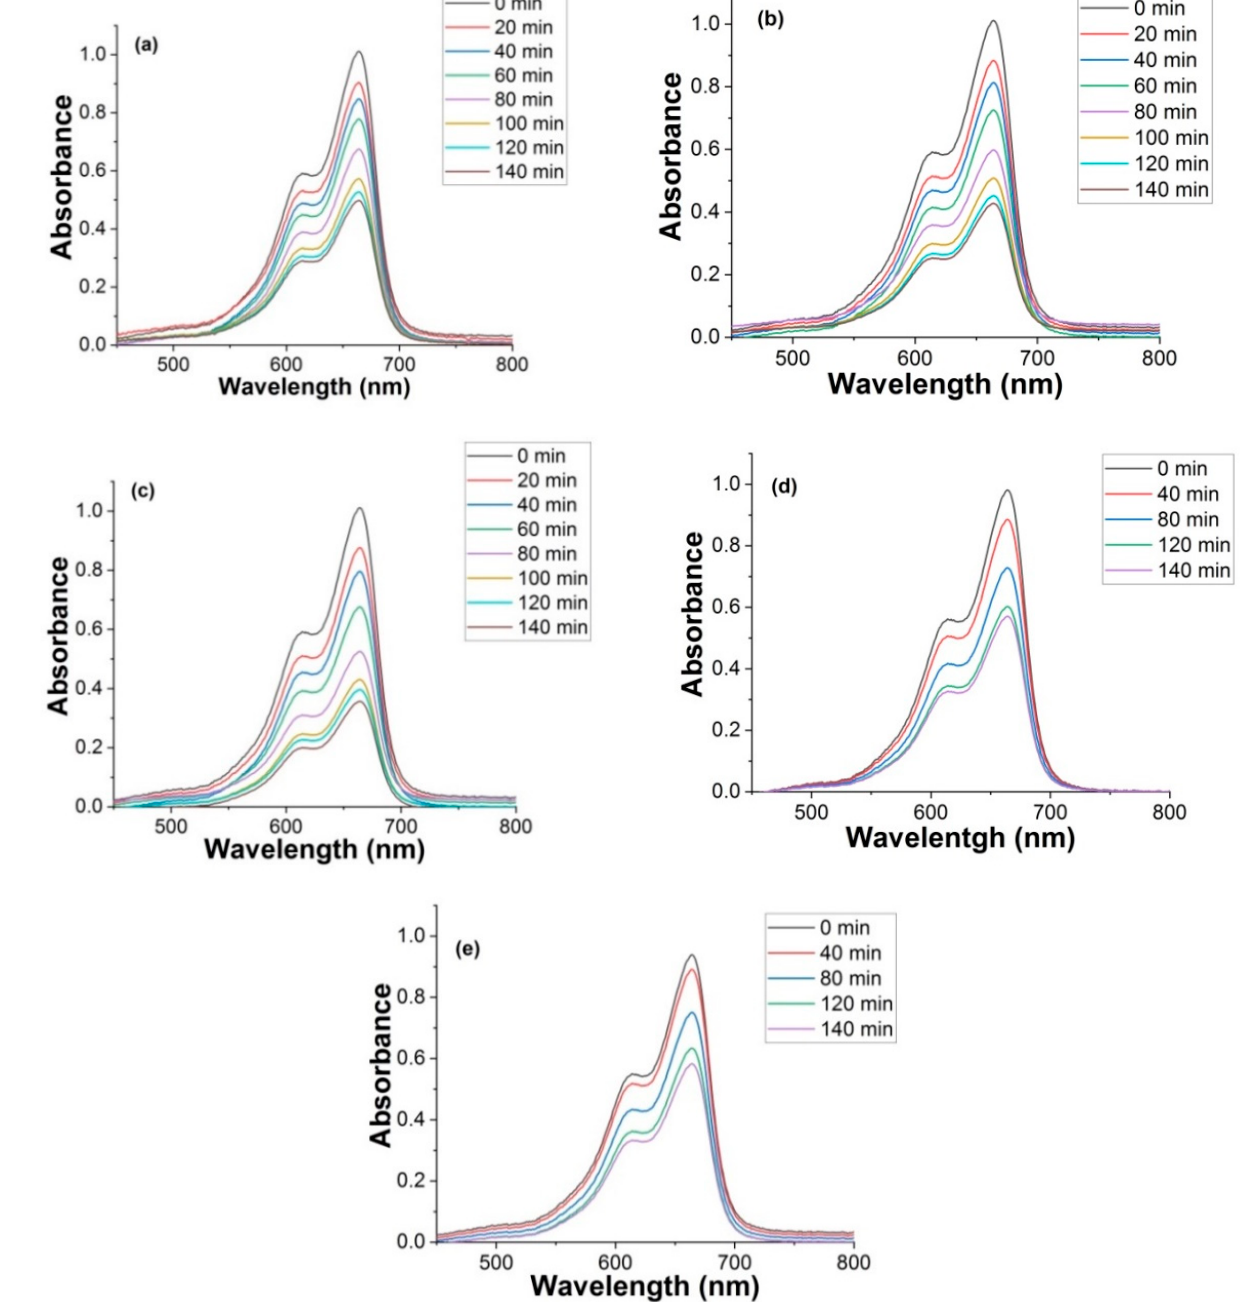
Figure 6. ( a ) Zr1CrO 2 , ( b ) Zr3CrO 2 , ( c ) Zr5CrO 2 , ( d ) Zr7CrO 2 , and ( e ) Zr9CrO 2 degradation of MB dye vs. contact time.